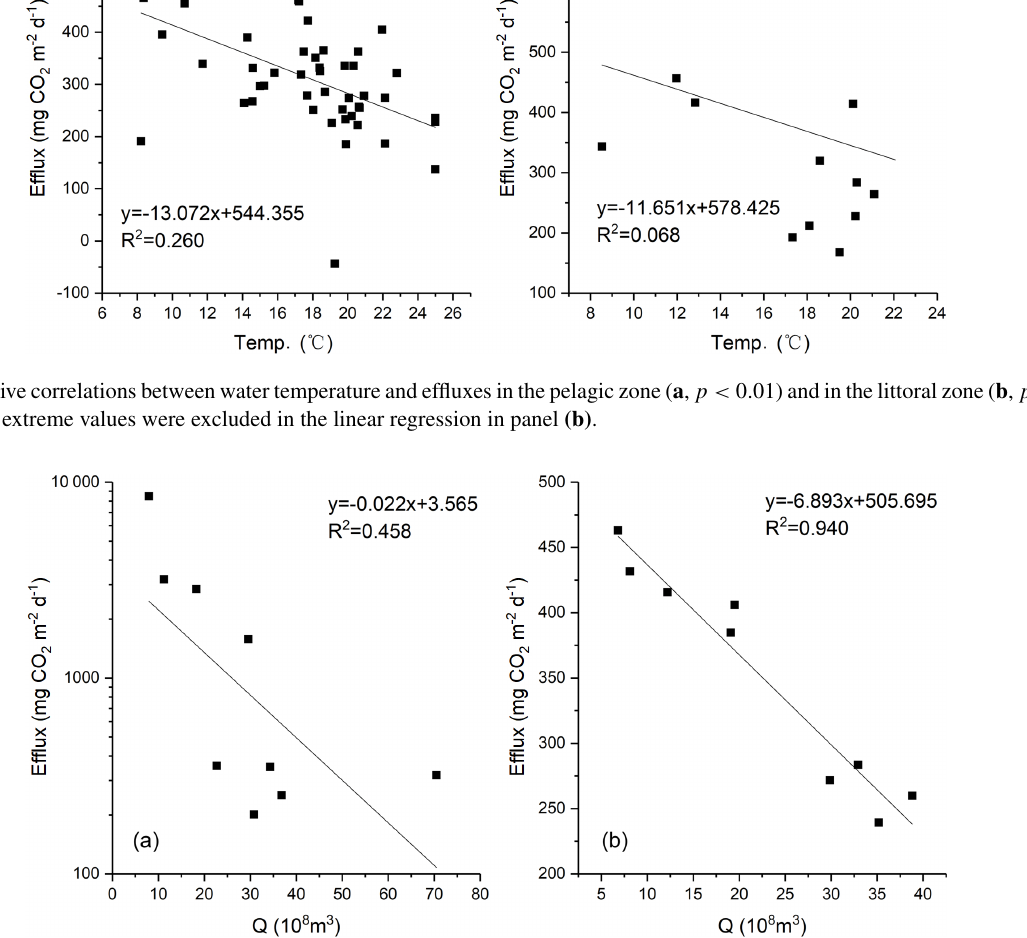
Figure 9. The negative correlation between water discharge and CO 2 efflux at the riverine inlet (R1, a , p < 0 . 01) and outlet (D, b , p < 0 .